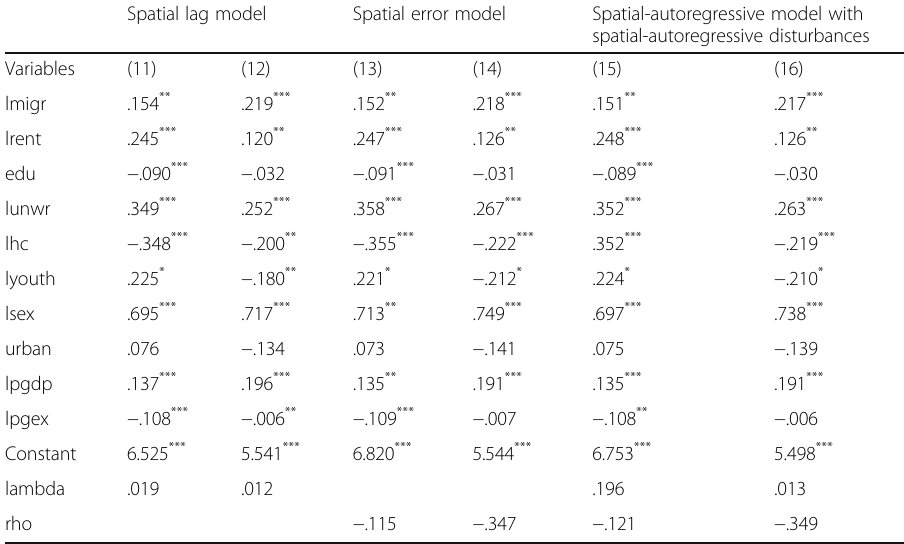
Table 4 Regression of influential factors for crime rates: Spatial regression analysis Spatial lag